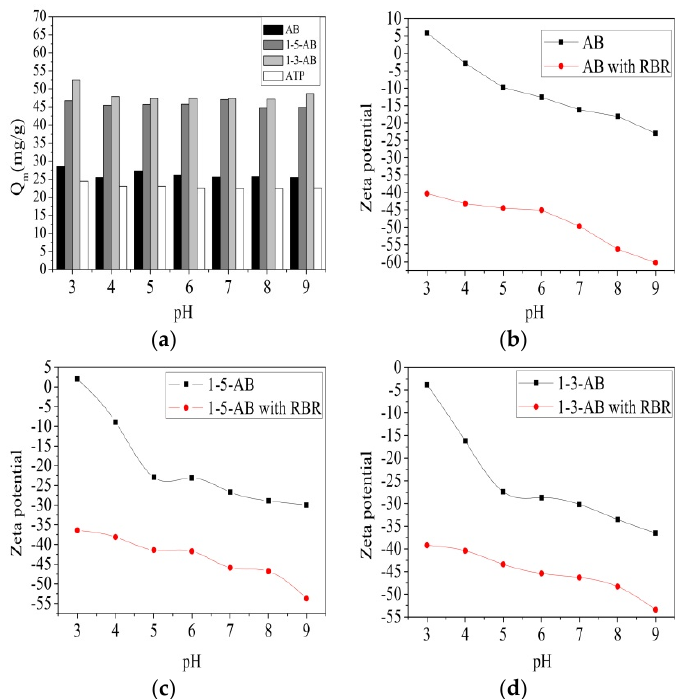
Figure 5. Effects of initial pH on the adsorption of RBR on the biochar samples: ( a ) effect of pH on the adsorption capacity of the three biochar samples, ( b ) effect of pH on the zeta potential of AB, ( c ) effect of pH on the zeta potential of 1 ‐ 5 ‐ AB, and ( d ) effect of pH on the zeta potential of 1 ‐ 3 ‐ AB.